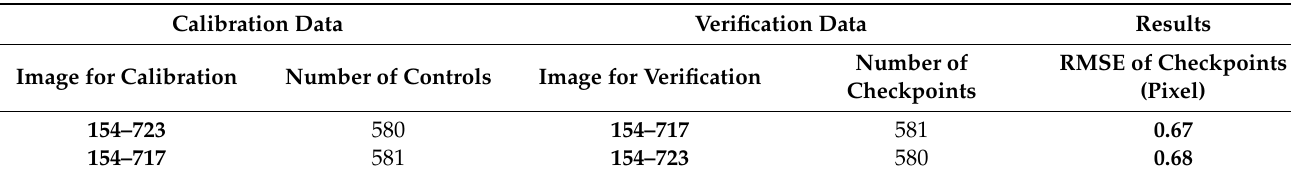
Table 4. Mutual verification results based on dense matches.